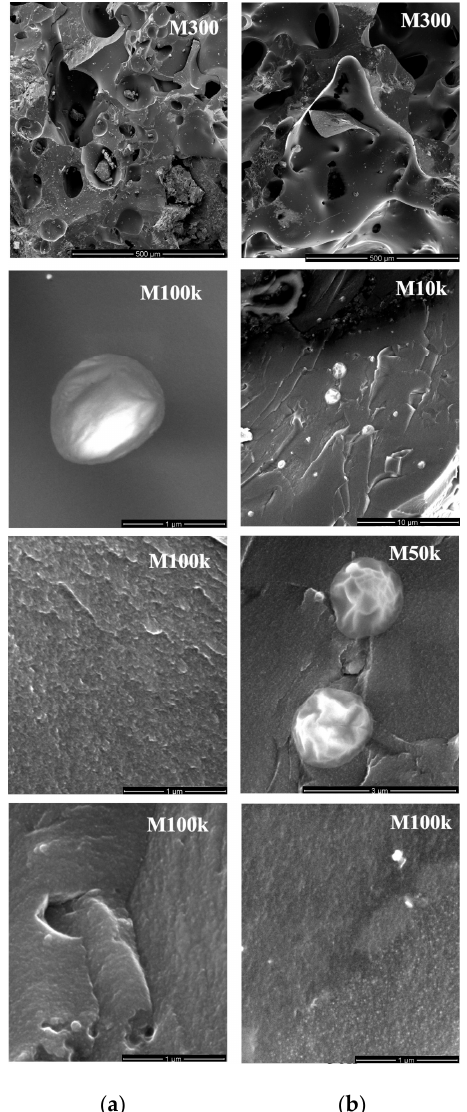
Figure 9. The SEM images of material from the gas ‐ saturated zones of plastic layer in the charge of fresh ( a ) and thawed ( b ) fresh ( a ) and thawed ( b ) coals.